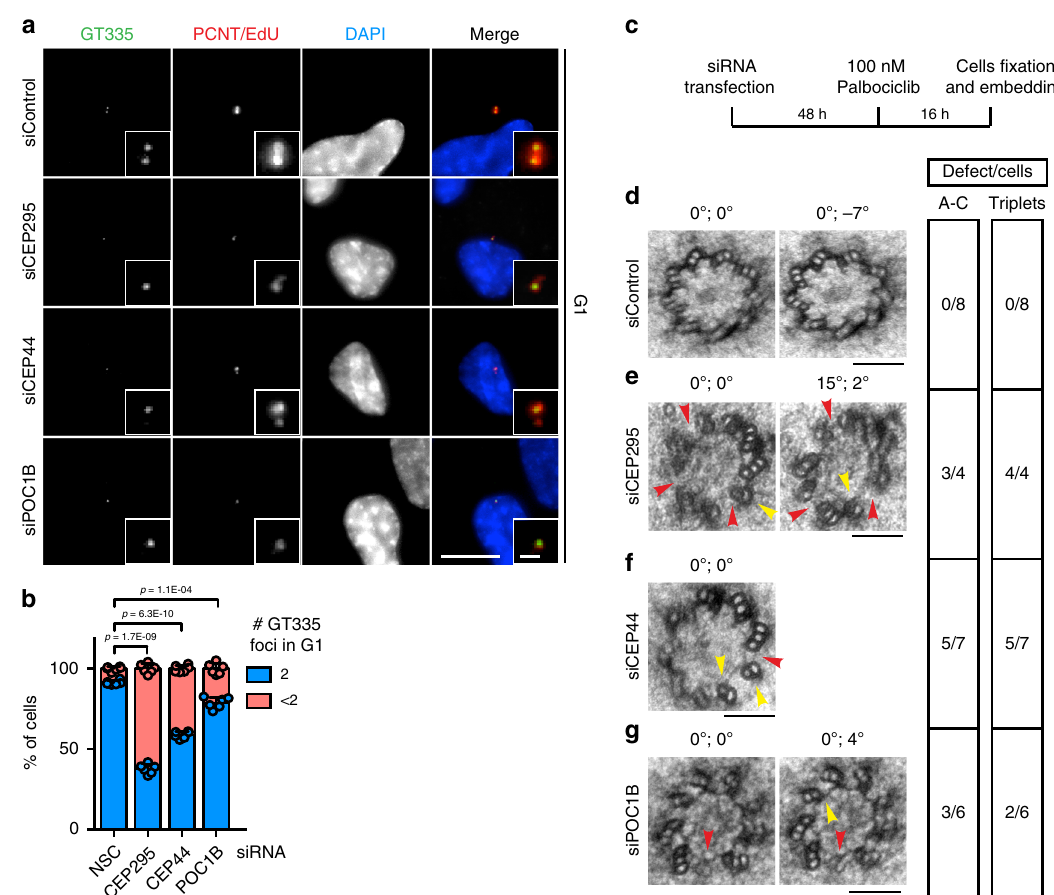
Fig. 6 Conversion molecules provide structural integrity of centrioles. a IF samples of cells treated with siControl, siCEP295, siCEP44 or siPOC1B. Depletions of siCEP295, siCEP44 or siPOC1B generated G1 cells (Cenp-F in Supplementary Fig. 11b) with <2 centriole glutamylation foci (GT335 signals) different from siControl. b Quanti fi cations of a . 62.4 ± 3.0% of G1 siCEP295 cells showed <2 GT335 foci; 41.2 ± 2.2% in siCEP44 cells; 21.3 ± 3.5% in siPOC1B cells. Data are presented as mean ± s.d., statistics were derived from two-tail unpaired t -test analysis of n = 6 biologically independent experiments and source data are provided as a Source Data fi le. c Scheme of the experimental procedure of the EM analysis of dCs. d – g EM images of turned and tilted sections of proximal region of daughter centrosomes in G1. The two values on the top of the image give the sample turning and tilting degrees, respectively. Red arrowheads indicate open structural defects (A-C linker absent), while yellow ones highlight defects of triplets. The side table (right) shows quanti fi cation of the number of cells showing these defects. While in d G1 siControl cells there was no structural defect, in e siCEP295, f siCEP44 and g siPOC1B G1 cells dCs showed defects in the triplets and A-C linker formation. ( a scale bar: 10 μ m, magni fi cation scale bar: 1 μ m; d – g , scale bars: 100